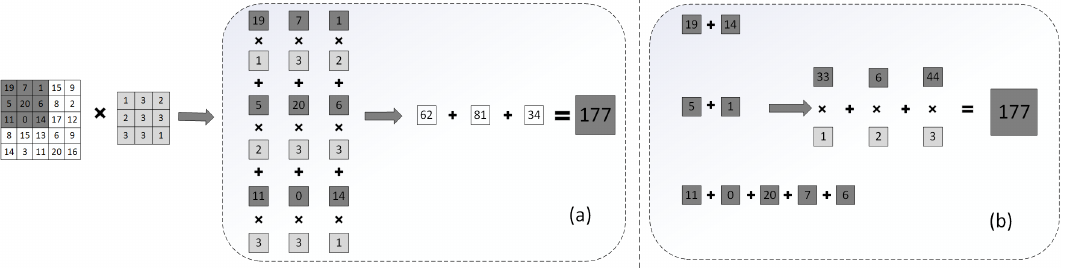
Figure 4. Example of the hardware acceleration